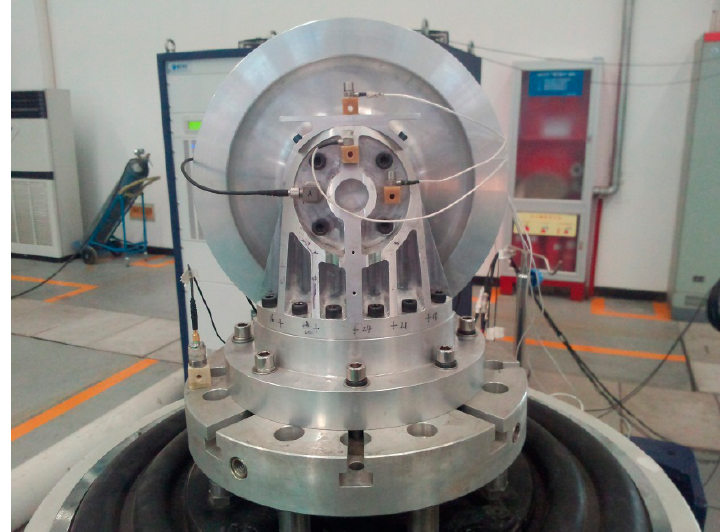
Figure 6. Configuration of the reference scheme.